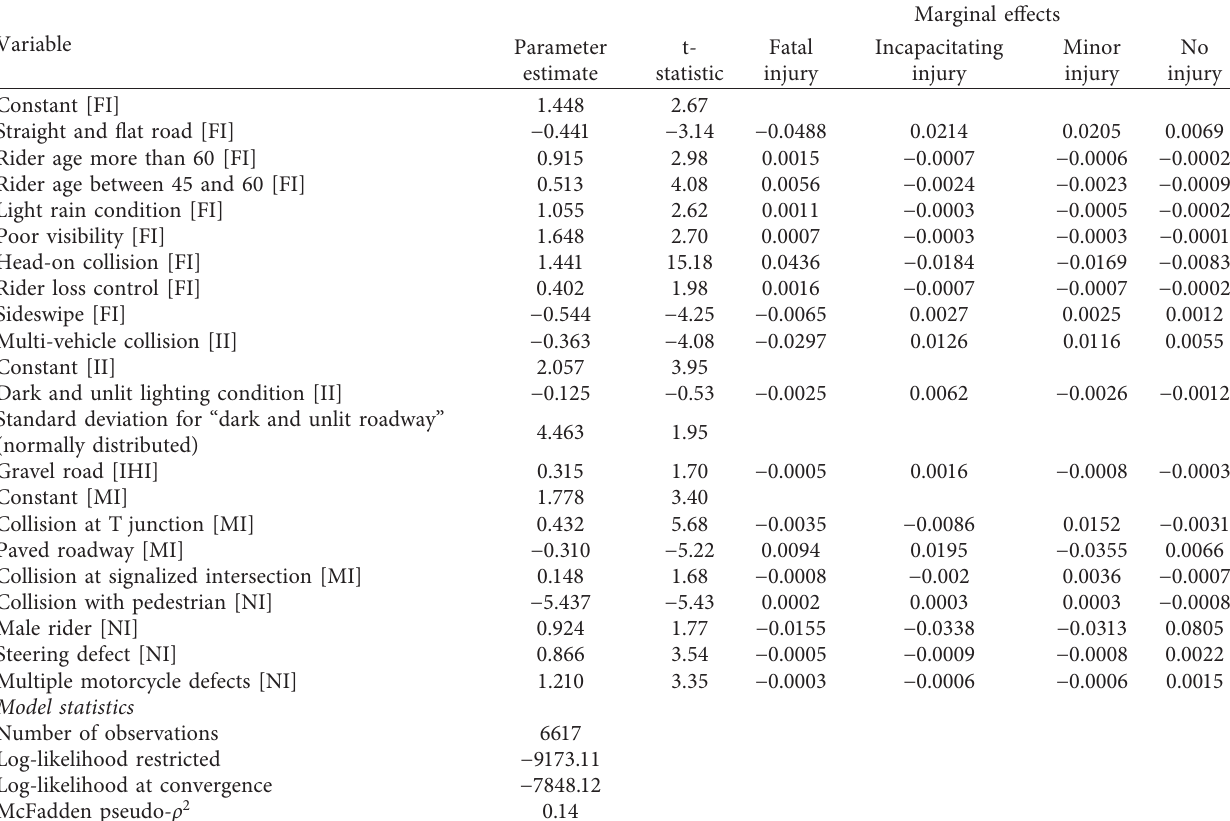
Table 4: Mixed multinomial logit model estimation results for urban motorcycle